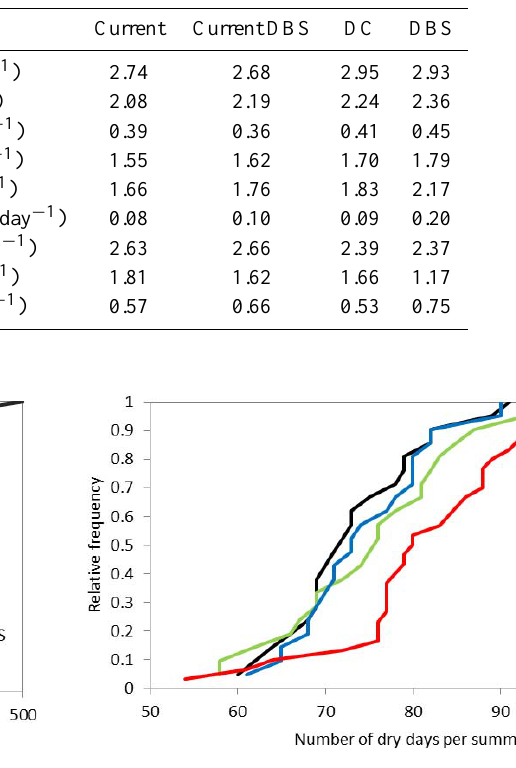
Fig. 7. Cumulative histogram of the number of dry days per summer for the current scenario as well as for the future scenario (DC and DBS methods,